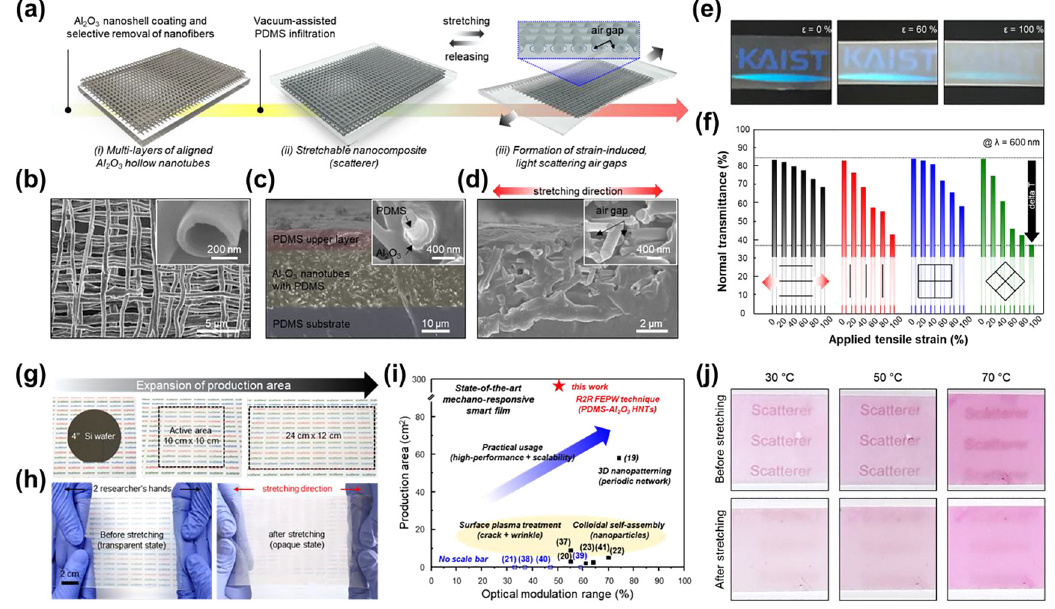
Figure 11: Design of scatterer based on aligned nanofiber structures. (a)Schematicillustrationsshowingthefabricationproceduresforthescatterer.(b)Top-viewSEMimageofAl 2 O 3 hollownanotubesonaPDMS substrate. (c) A cross-sectional view of the nanocomposite in fi ltrated with PDMS. (d) Strain-induced air gap formation in the composite. (e)Digitalimagesofascattererwitharhombus-likestructureand(f)normaltransmittancevaluesofscattererswithvariousmorphologiessuch as parallel, vertical line structure, check pattern, and rhombus-like structure. (g) A large-area scatterer before and (h) after stretching. (i) Comparison of the previously reported production areas of scatterers. (j) The thermal-dependent color change in a scatterer designed